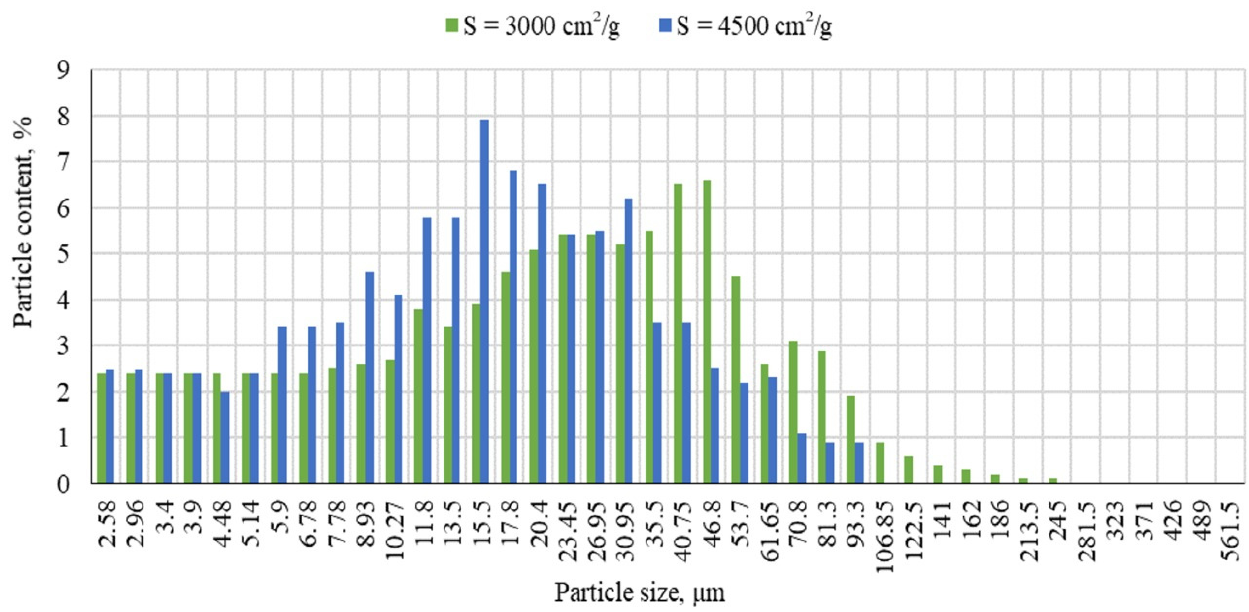
Figure 1. Particle size distribution of Portland cement.